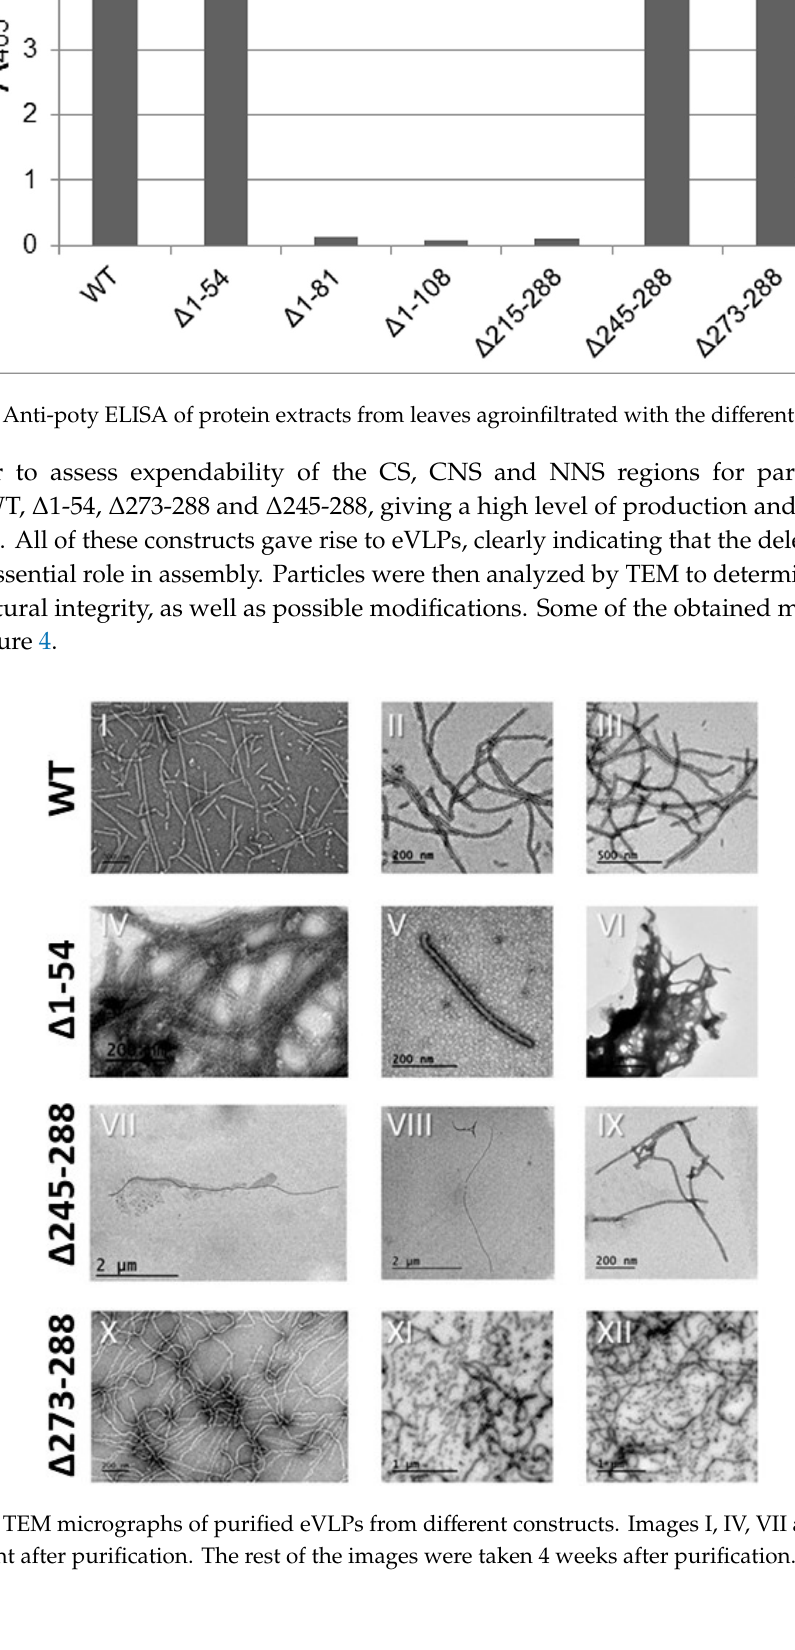
5 of 10 Figure 2. Design of coat protein truncated versions. NNS: CP N-terminal non-solved region (aa 1–65). NS: CP N-terminal-solved region (aa 66–97). CS: CP C-terminal-solved region (aa 245–272). CNS: CP C-terminal non-solved region (aa 273–288). Each of these domains is represented with different colors: NNS (striped pink), NS (solid pink), CS (solid blue), and CNS (striped blue). The first construct is just wild type CP, whose plant-made eVLPs have already shown their usefulness in previous nanobiotechnological applications [19,20]. In this case, TuMV eVLPs-WT (wild-type) show a morphology similar to virion particles, with a helical symmetry and a size range of 700–1000 nm [25]. eVLPs have also been developed in another potyvirus, PVY, through a yeast